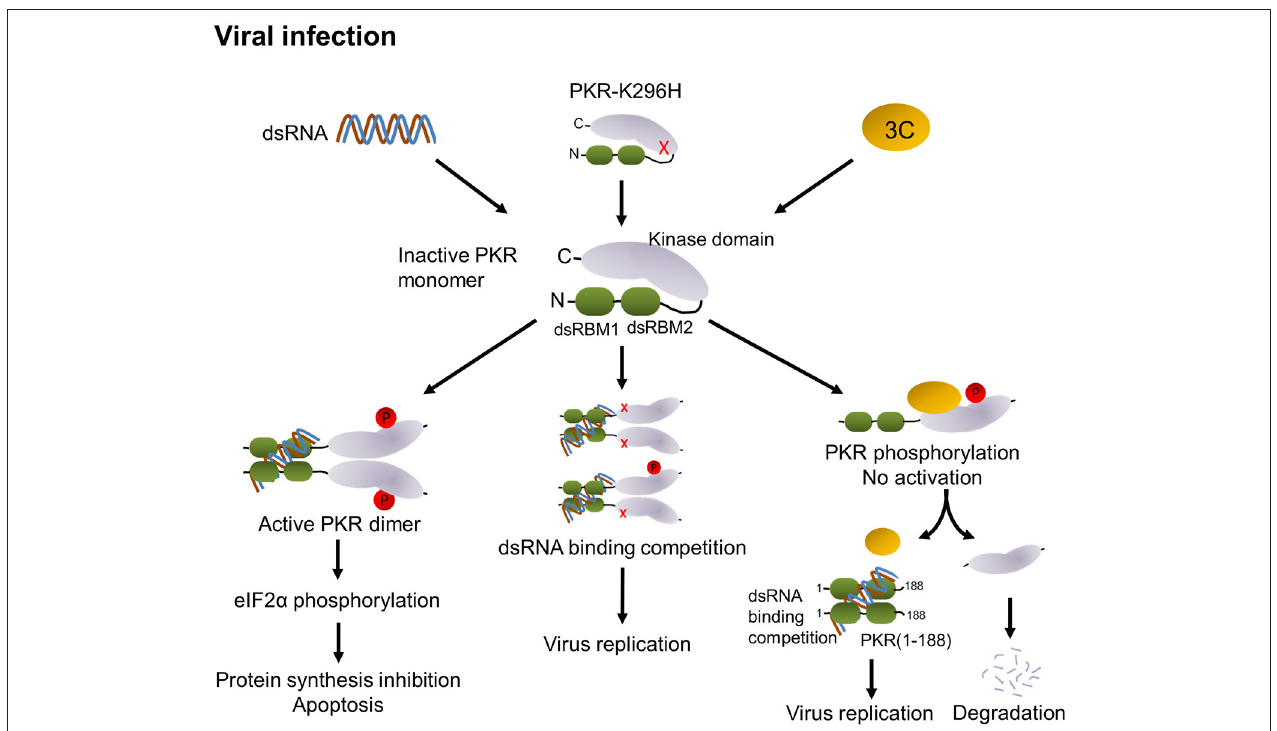
FIGURE 8 | Proposed model of modulation of PKR function by EV-A71 3C protease. PKR consists of two dsRNA-binding motifs (dsRBM1 + dsRBM2 in green) and the C-terminal kinase domain (gray). In general, binding of viral dsRNA leads to dimerization and autophosphorylation of PKR. Active PKR subsequently phosphorylates its substrate eIF2 α , which results in translation inhibition and apoptosis (left). Overexpression of the PKR-K296H mutant (cartoon molecule with a red x) competes with endogenous PKR for dsRNA binding to attenuate PKR activation (middle). In EV-A71 infection, 3C interacts with PKR, which may block its dimerization. Then, 3C cleaves PKR to release dsRNA-binding motifs, which may compete with PKR for the recognition of dsRNA, thereby attenuating PKR activation and increasing viral replication